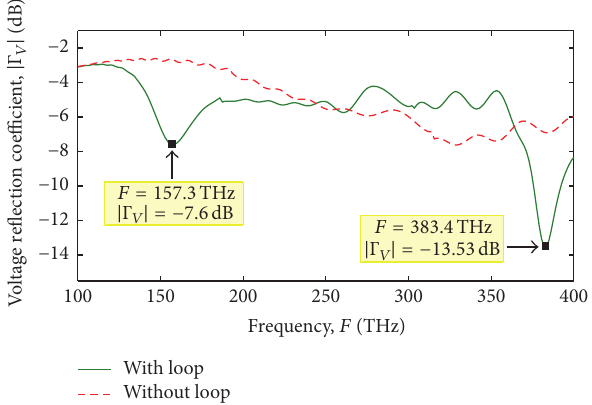
Figure 18: Voltage reflection coefficient as a function of frequency; the parameters are ℎ 𝑑 = 200 nm, 𝐿 = 1200 nm, 𝑎 𝑑 = 𝑎 𝐿 = 𝑎 𝑒 = 20 nm, 𝑑 𝑑 𝑑 𝑁 𝑁 𝑑 𝐿 = 60nm, 𝑒 = 50 nm, 𝑊 = 50 nm, 𝐻 = 20 nm, ℎ𝑑 = 5, 𝑊𝑒 = 4, 𝑁 𝐻𝑒 = 13, 𝑁 𝐿 = 29, and 𝑁 𝑡 = 104.